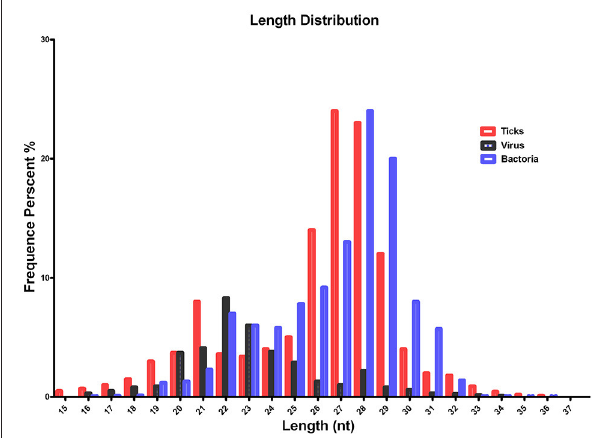
FIGURE 1 | Summary of the tag length distribution following the sequencing and annotation of small RNA from Hyalomma rufipes . The length of the small RNAs varied between 18 and 30 nt. Length distribution analysis is helpful when elucidating the composition of small RNA samples. For example, miRNA is normally 21 or 22 nt, siRNA is 24 nt, and piRNA is 30 nt. The x-axis represents the length of the small RNAs. The y-axis represents the percentage frequency of small RNAs of specific lengths among the sequencing reads. Red indicates the length distribution of total clean reads from ticks and the first peak generated by the Dicer enzyme; the second peak was generated by the Piwi enzyme. Black indicates the length distribution of SCRV. The peak was mediated by Dicer activity. Blue indicates the length distribution produced by Dicer and Piwi from the bacteria communities. Nt indicates nucleotides.